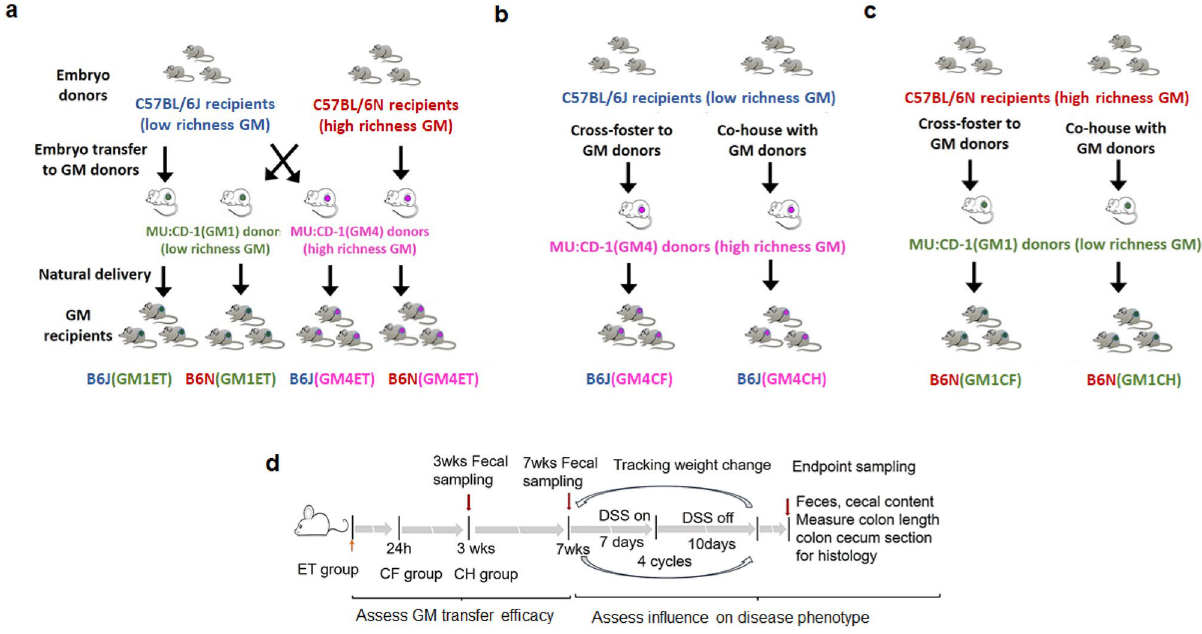
Figure 1. Experimental design of GM transfer studies and chronic DSS colitis. ( a) Substrain controlled transfer of GM1 and GM4. ( b) Transfer of GM4 using cross fostering and co-housing methods. ( c) Transfer of GM1 using cross fostering and co-housing methods. ( d) Timeline of DSS treatment to induce chronic